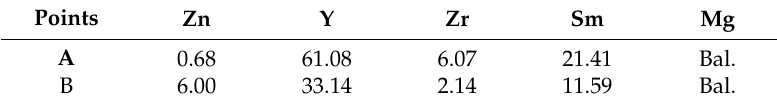
Figure 9. High magnification SEM images of Y-rich compound in the as-cast Mg-3Y-3.5Sm-2Zn-0.6Zr alloy: ( a ) Without UST; ( b ) with UST. Table 5. EDS results corresponding to the selected points in Figure 9 (wt %).